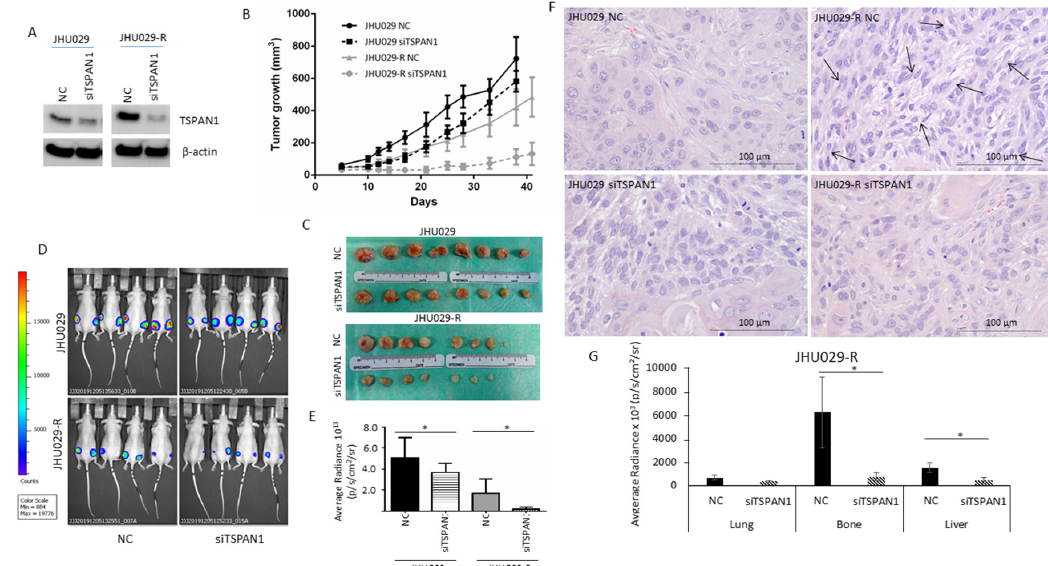
Figure 5. Impact of TSPAN1 inhibition in vivo. ( A ) JHU029 and JHU029-R cells were transduced with siTSPAN1 and injected into immunosuppressed mice. TSPAN1 inhibition was monitored in cultured cells at day 2 after transfection. ( B ) Graph representing the growth of mice tumors originated from the indicated cell lines upon TSPAN1 inhibition vs. negative controls (NC). Data are expressed as mean ± SD. Significant differences were observed between JHU029 NC vs siTSPAN1 (days 10–28), and JHU029-R NC vs siTSPAN1 (days 12–41). Unpaired Student’s t -test. ( C ) Pictures of the tumors formed in the indicated group of mice. ( D ) Pictures of the mice tumors at the end point of the experiment. The luminescent signal was taken by the IVIS apparatus. ( E ) Quantification of the luminescent signals of tumors were acquired by Living Image software, and graphed. Unpaired two-tailed Student’s t -test, * ( p < 0.05). ( F ) Representative images of H&E staining for the indicated mice tumors. Note the presence of a fusocellular pattern (arows) in the resistant cells but not in parental cells. The fusocellular pattern, indicative of EMT activation, was reverted in the TSPAN1-depleted tumor subgroup (JHU029-R-NC vs. JHU029-R-siTSPAN1). Scale bar: 100 μ m ( G ) Quantification of micrometastases ex vivo based on luminescent signals acquired by Living Image software in the indicated organs from the JHU029-R mice tumors. Unpaired two-tailed Student’s t -test, * ( p < 0.05).